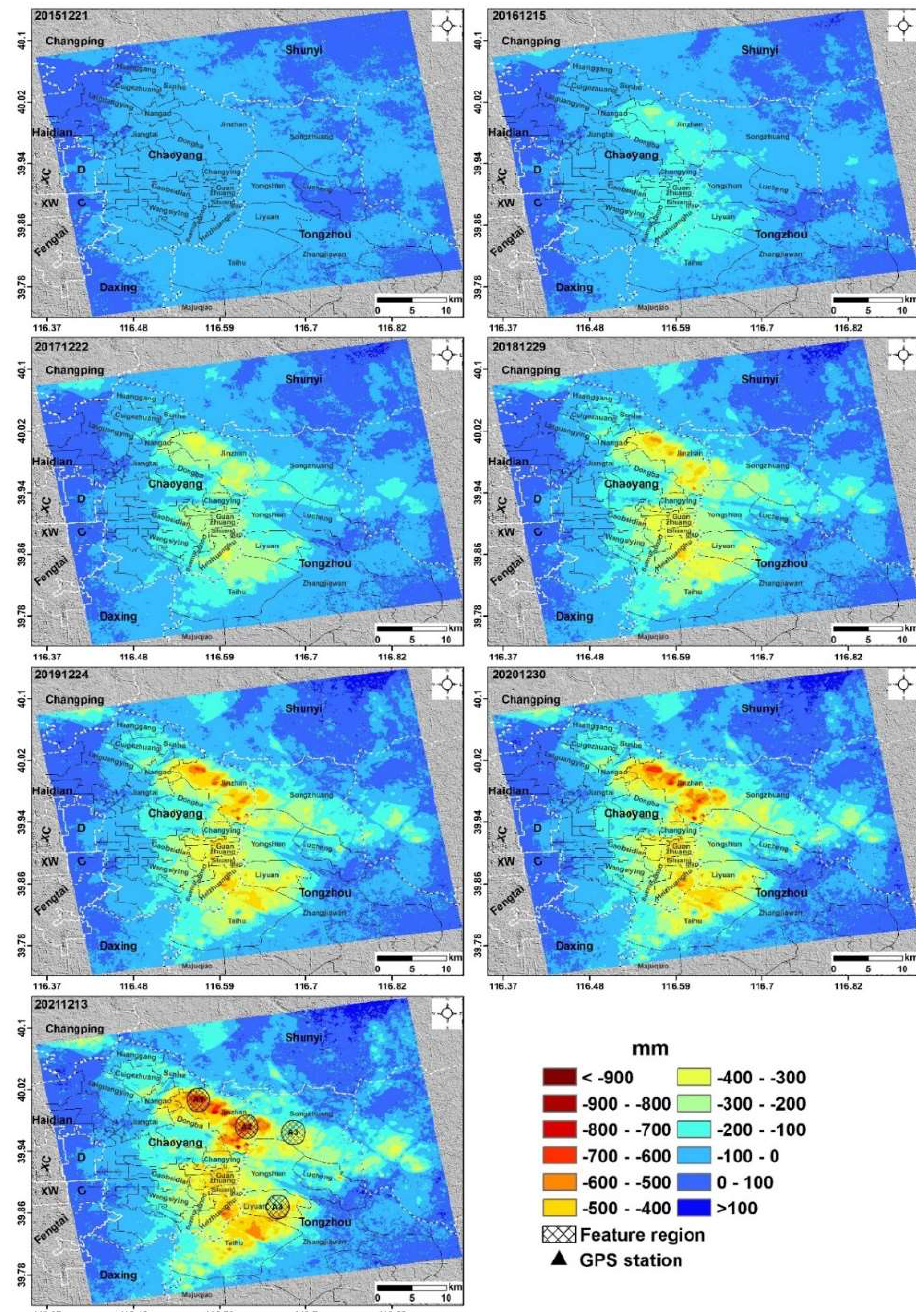
Figure 5. Cumulative vertical deformation from 30 July 2015 to 13 December 2021. The color bar indicates the vertical deformation in millimeters. The dashed white line is the county boundary of Beijing administrative district.